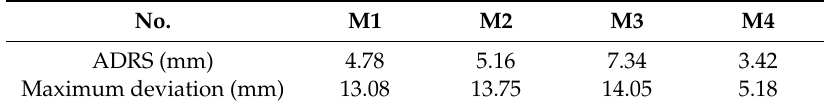
Table 9. The ADRS and the maximum deviation of each mirror in the final structure.